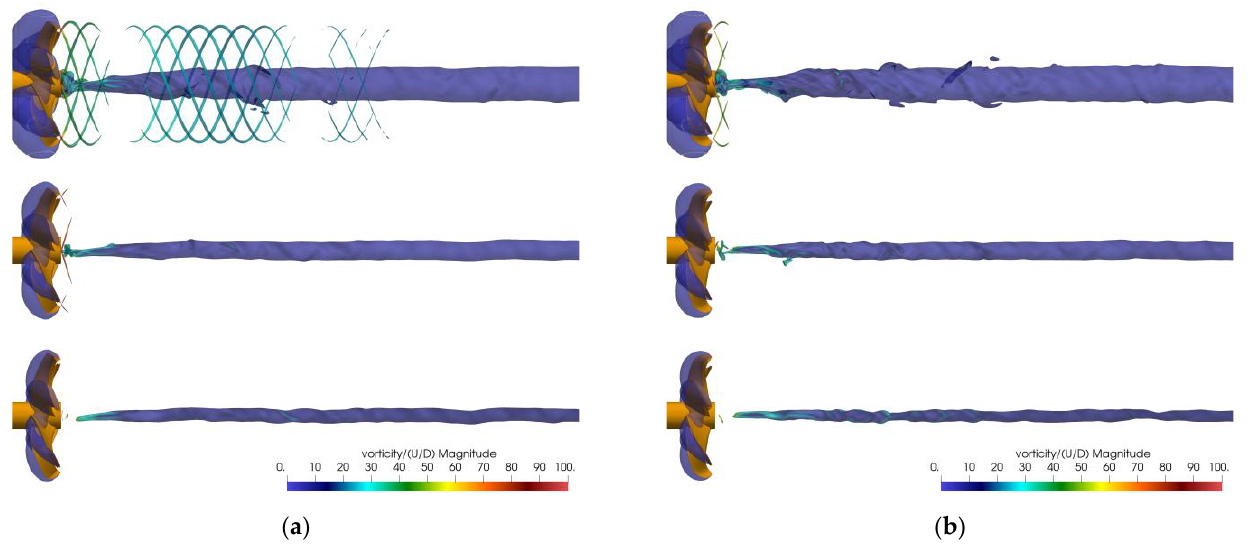
Figure 6. Instantaneous (22nd propeller revolution) isosurface of the pressure coefficient ( − C PN ) colored with the magnitude of vorticity scaled by U inf /D . From top to bottom: − C PN = 0.1, 0.2 and 0.3. Advance coefficient J equal to 0.9. ( a ) Conventional CLT; ( b ) New generation CLT.